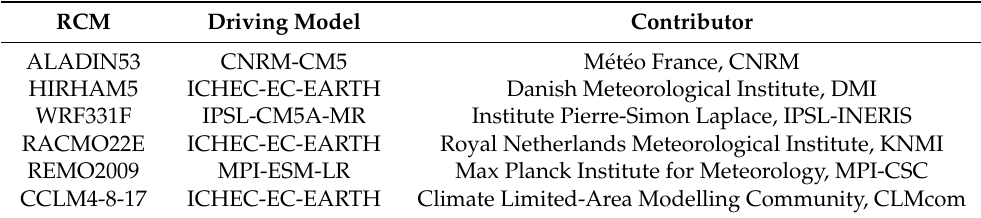
Table 1. Regional Climate Models (RCMs) and their respective driving models and contributors.